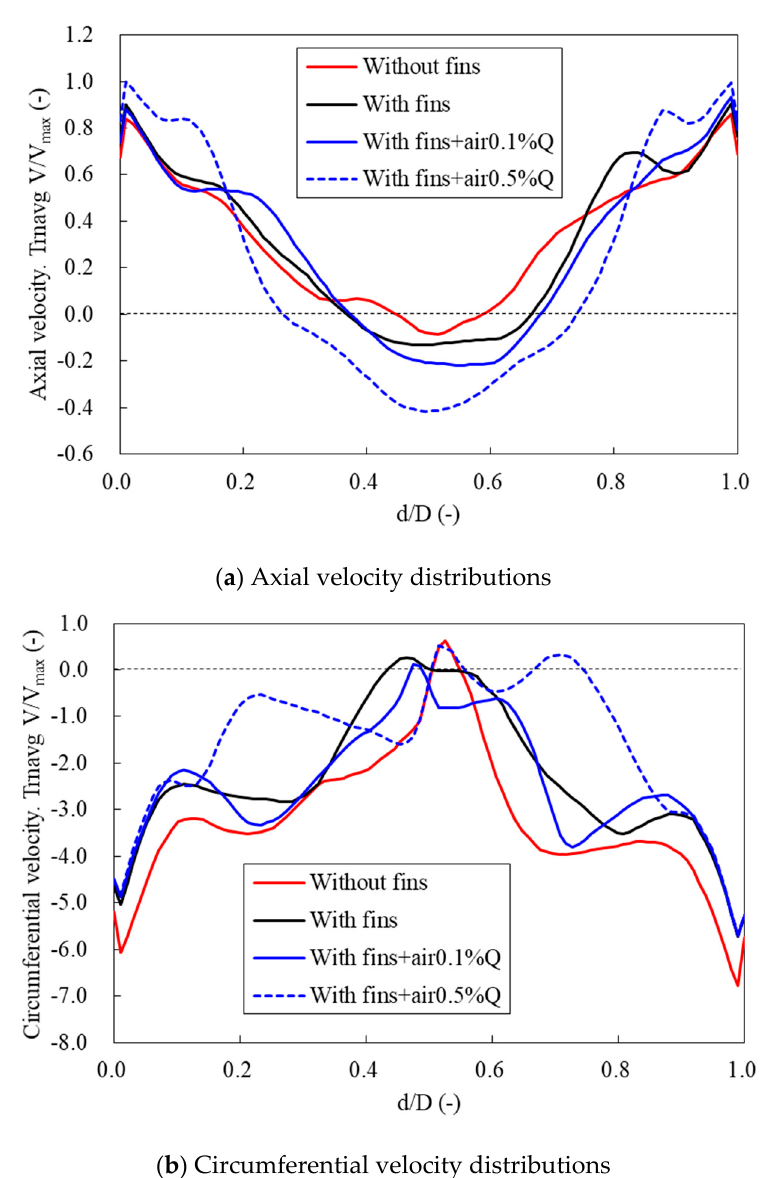
Figure 10. Velocity distributions associated with the observed line in the DT.